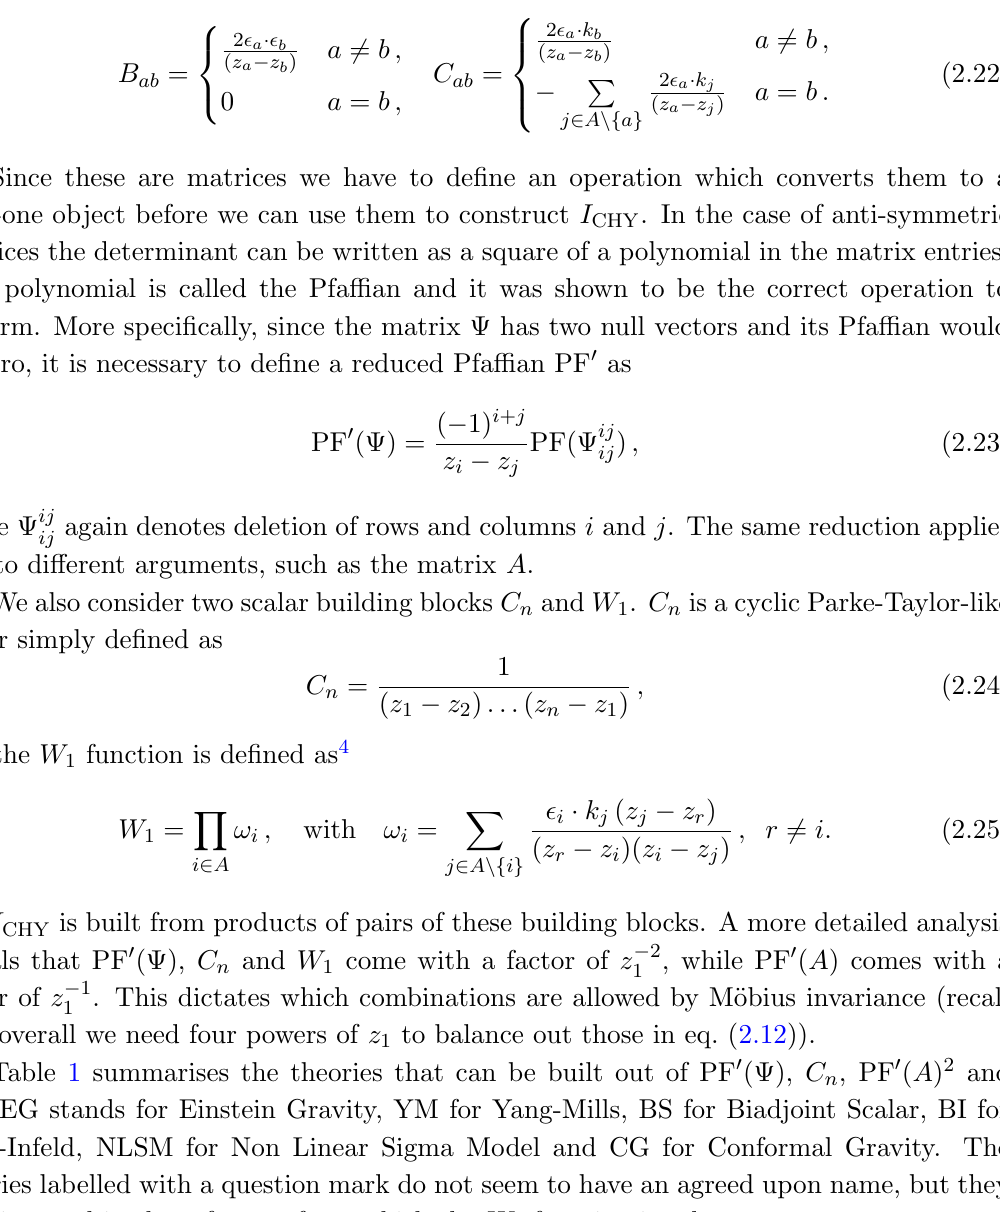
W : EG stands for Einstein Gravity, YM for Yang-Mills, BS for Biadjoint Scalar, BI for 1 Born-Infeld, NLSM for Non Linear Sigma Model and CG for Conformal Gravity.